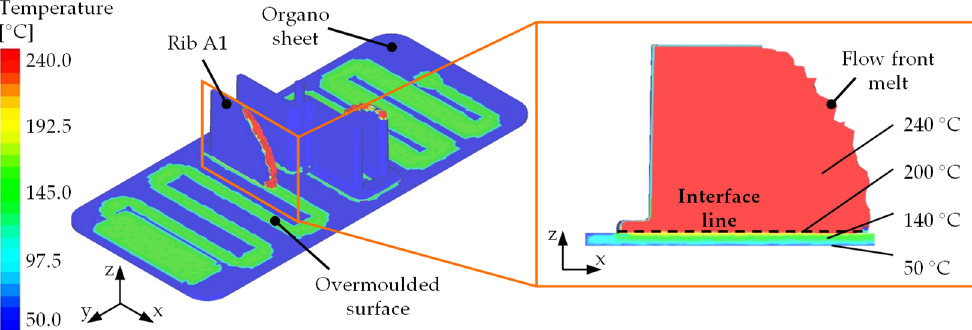
Figure 3. Temperature distribution from the overmoulding simulation (parameter set 6 “HiOrg”, timestep 0.36 s ) and cross-section view of rib A1 with exemplary temperature values.